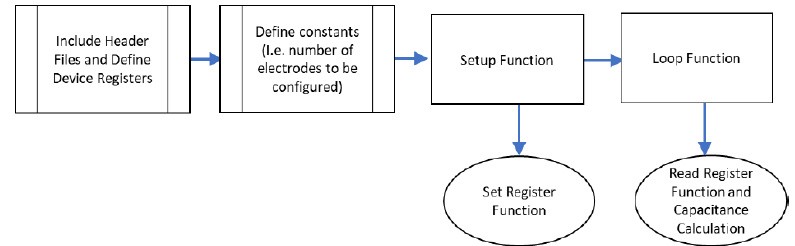
Figure 8. Pseudocode of the Arduino